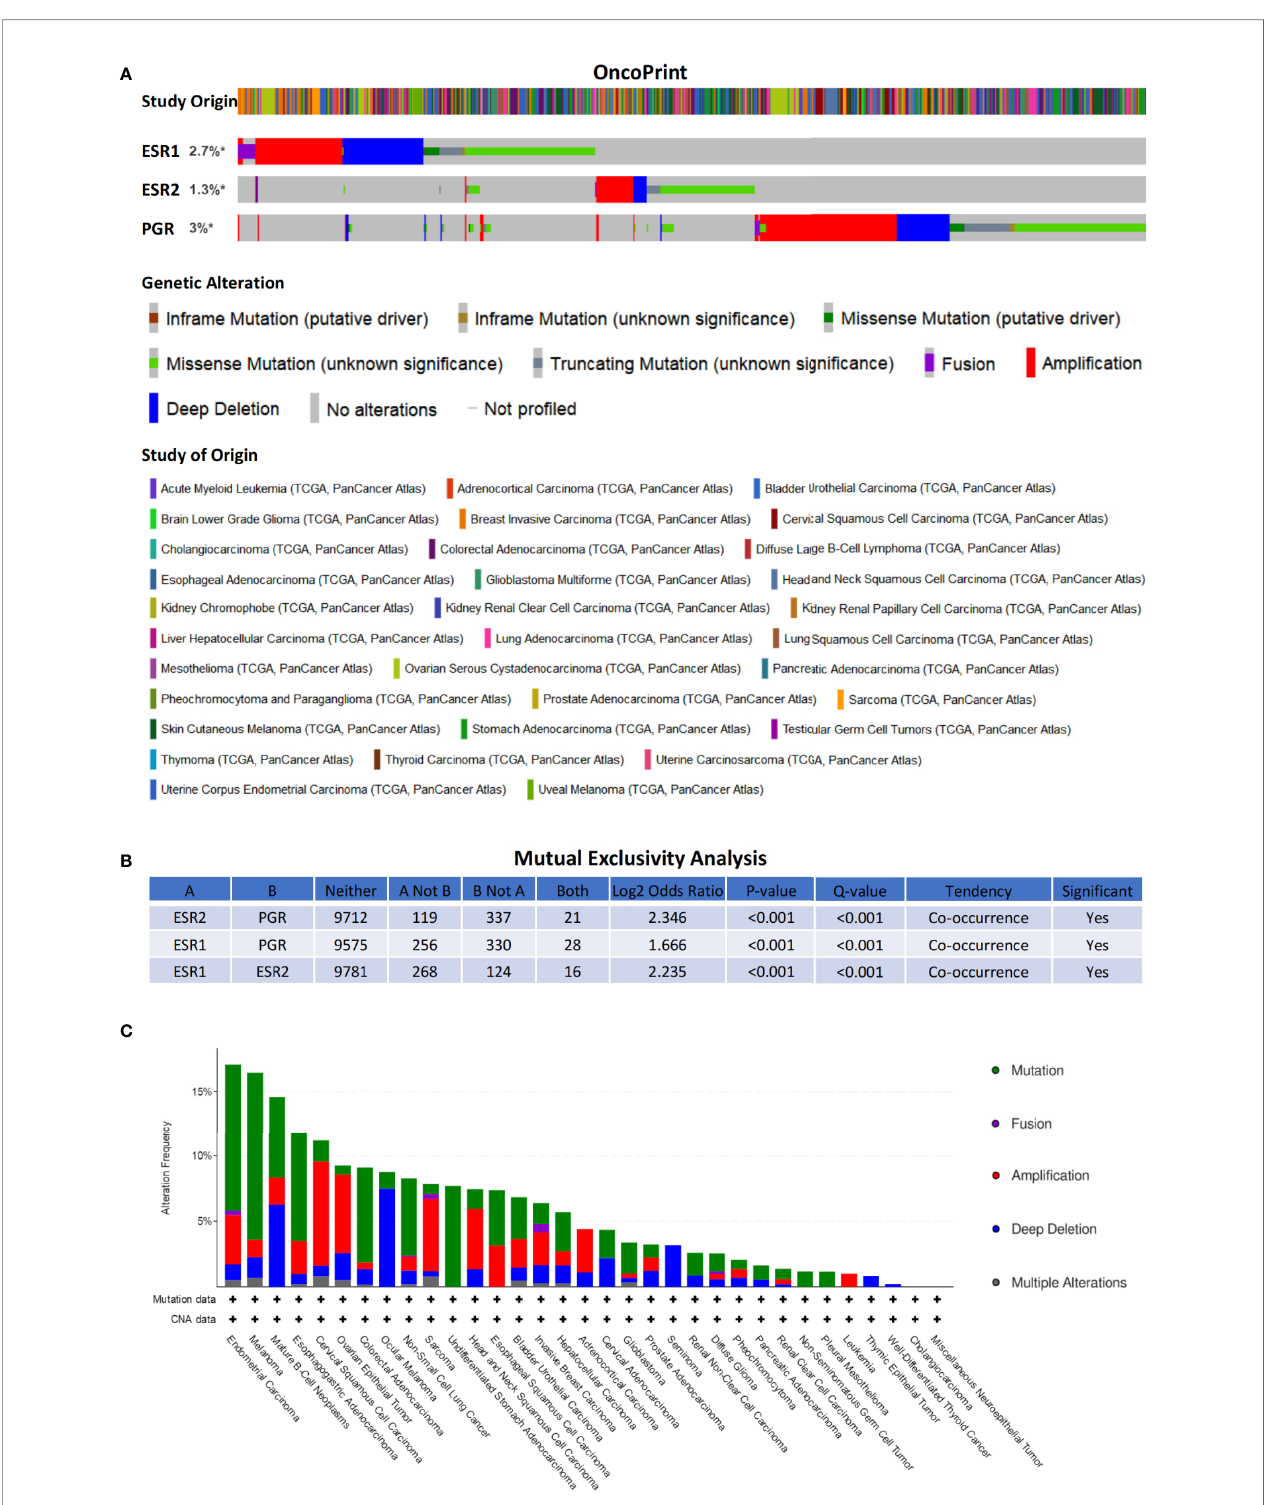
FIGURE 6 | Genetic alterations of ESR1 , ESR2 , and PGR across multiple cancer types. (A) Alteration landscape for ESR1 , ESR2 , and PGR across multiple cancer types. (B) Mutual exclusivity analysis between alterations of ESR1 , ESR2 , and PGR across multiple cancer types. (C) Cancer type summary of ESR1 , ESR2 , and PGR alterations across multiple cancer types. * indicates not-pro fi led samples existing in the enquired